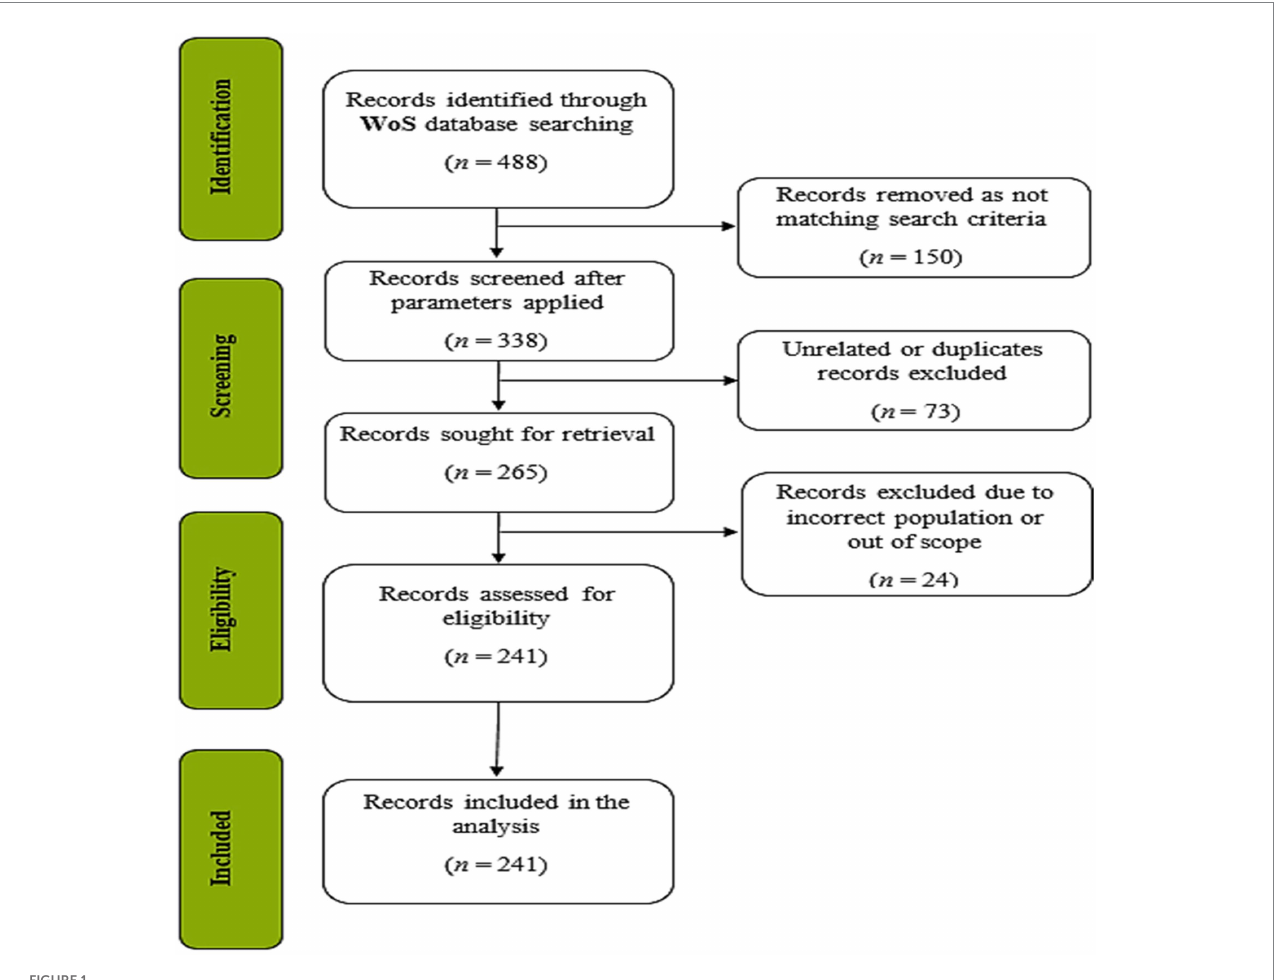
FIGURE 1 PRISMA flow